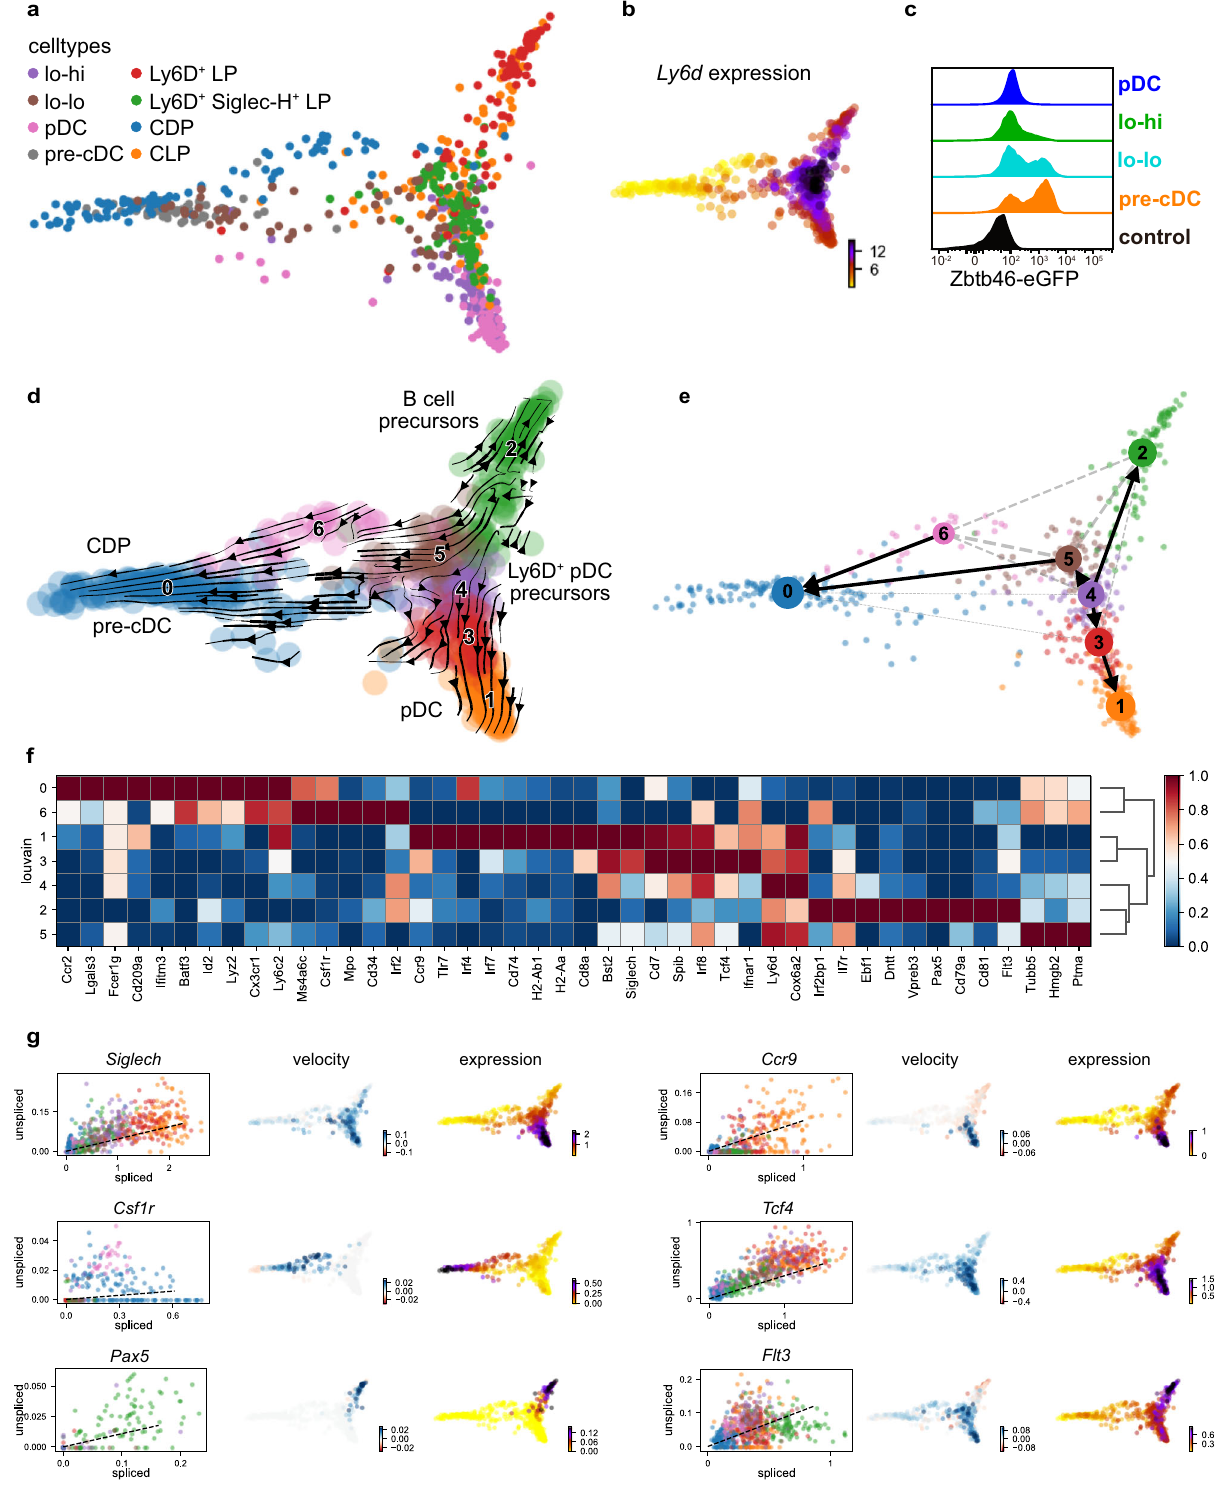
We next inferred trajectories between clusters using partition- based graph abstraction (PAGA) with directionality deduced from RNA velocity which uses a velocity-inferred pseudotime as prior (Fig. 2e). This analysis con fi rmed the continuous transition from Ly6D + Siglec-H + LP and the Ly6D + part of the lo-lo precursors (cl. 4) to lo-hi precursors (cl. 3) to pDCs (cl. 1). Cells in cl. 4 were also closely connected with B cell precursors (cl. 2).